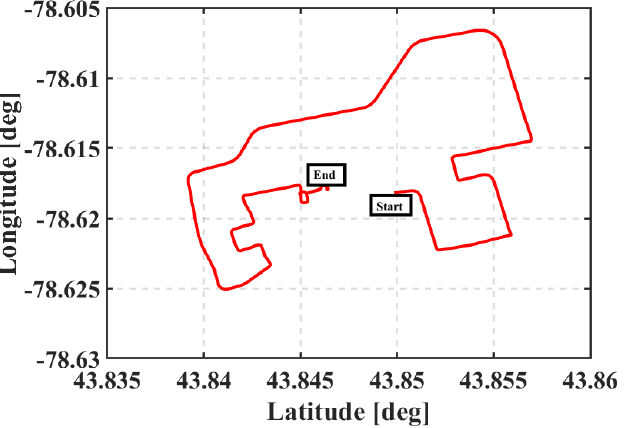
Figure 17. The trajectory of the third vehicular test, Toronto, Ontario, Canada (22 June 2020).